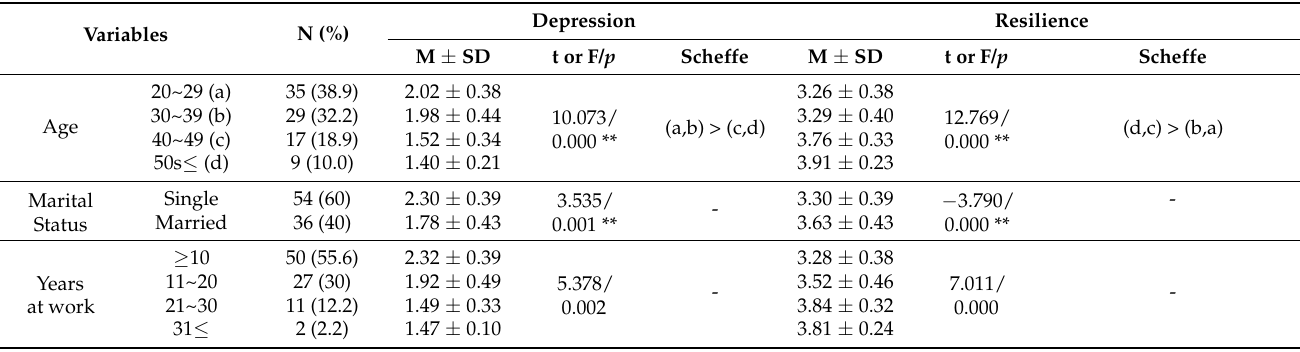
Table 1. Depression and resilience by general